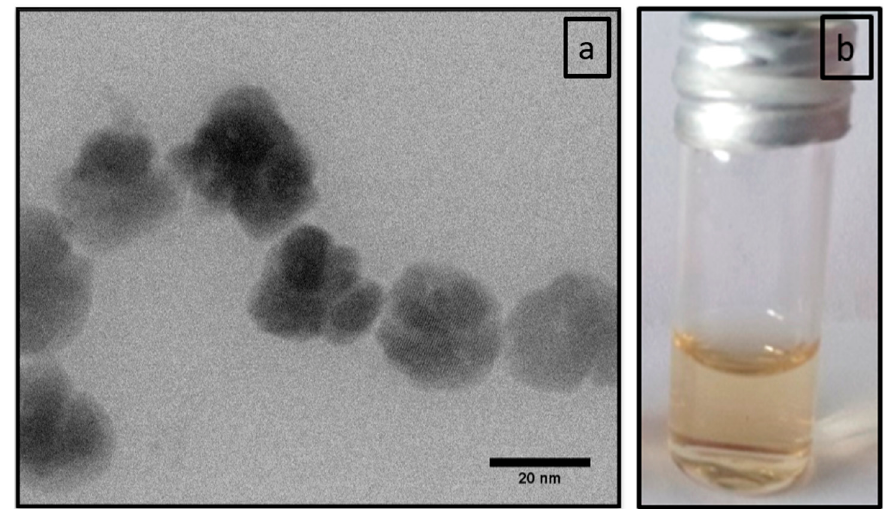
Figure 1. ( a ) STEM image of polyR-Fe 3 O 4 nanoparticles. ( b ) Image of vial with colloidal stable polyR-Fe 3 O 4 nanoparticles solution one year after synthesis.